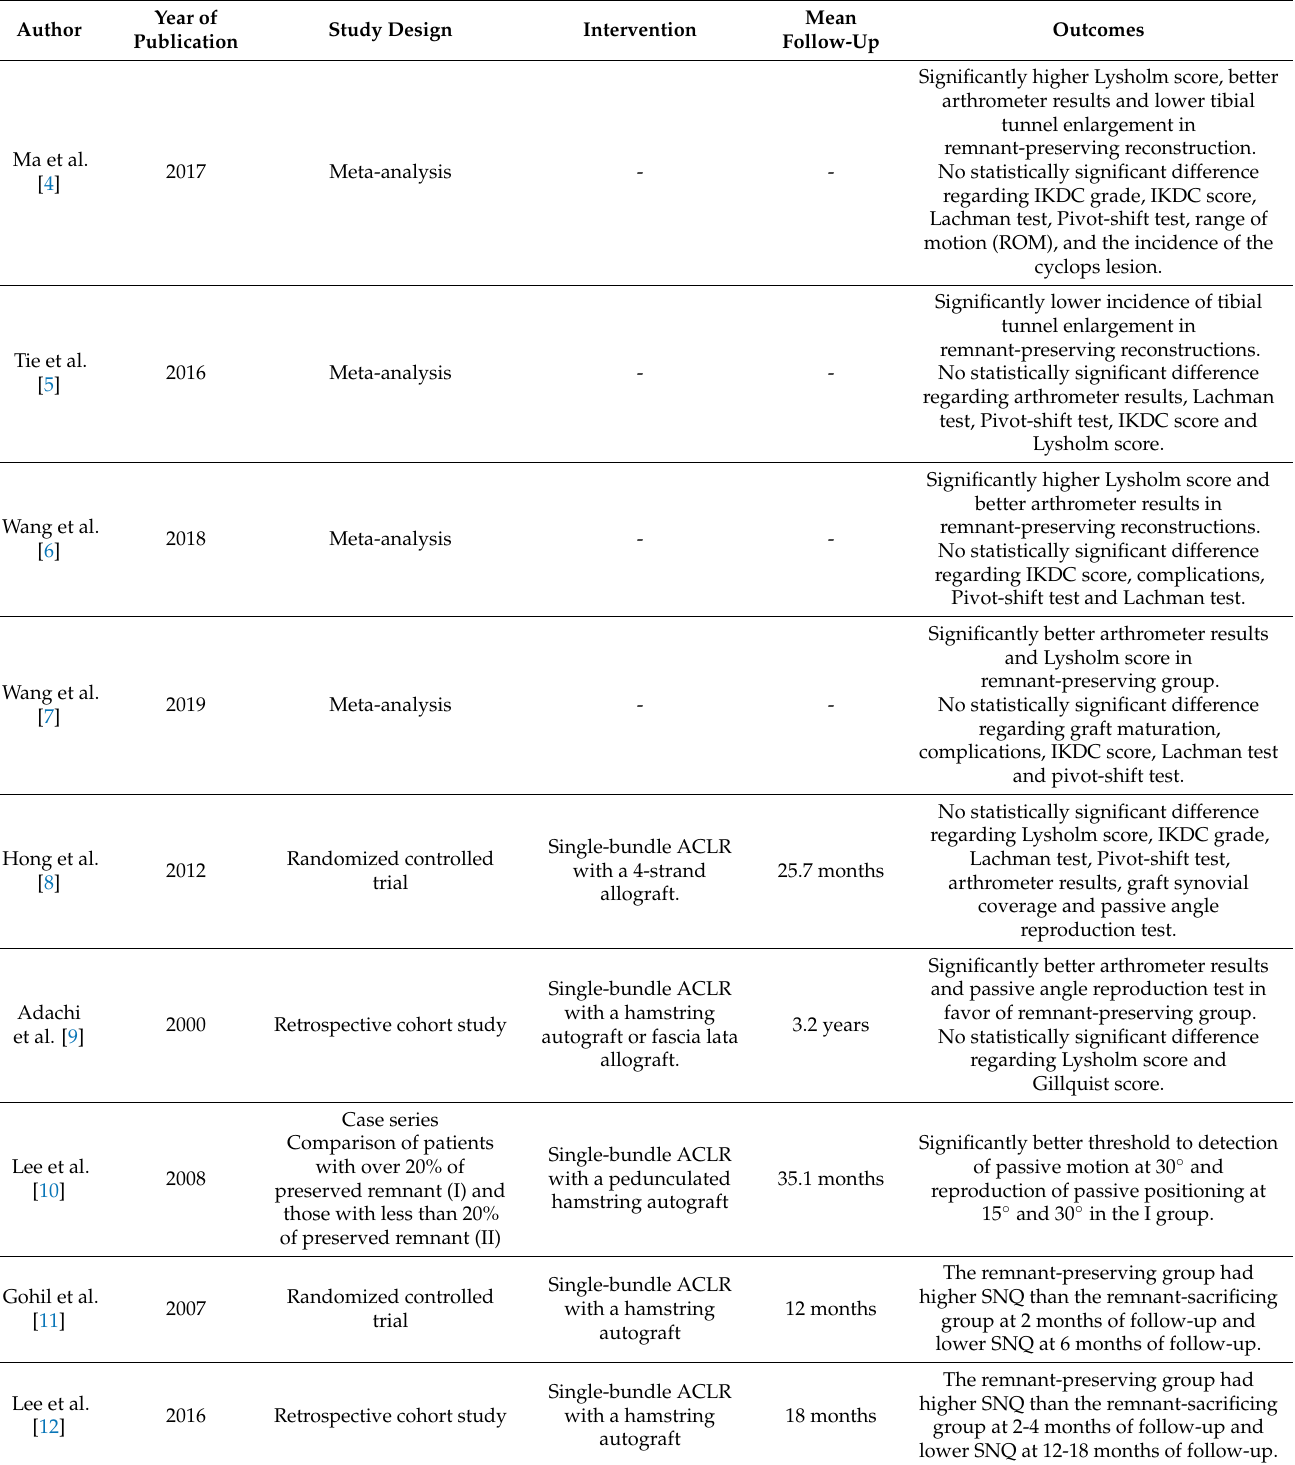
Table 1. Summary of available literature concerning remnant-preserving ACL reconstructions (Abbreviations: IKDC— International Knee Documentation Committee; ROM—range of motion; ACLR—anterior cruciate ligament reconstruction; SNQ—signal/noise